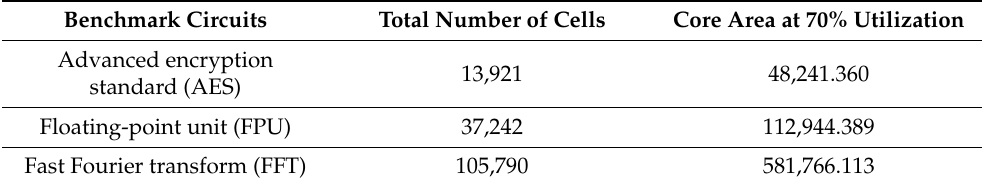
Table 1. Benchmark